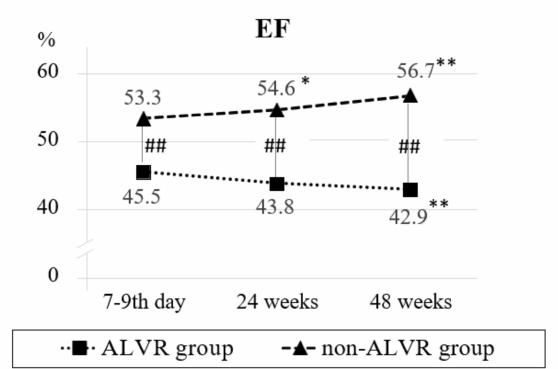
Figure 2. Dynamics of EF values in the comparison groups. Note: * p < 0.05, ** p < 0.01 are significant differences between the initial values and subsequent visits; ## p < 0.01 are significant intergroup differences. EF—ejection fraction.